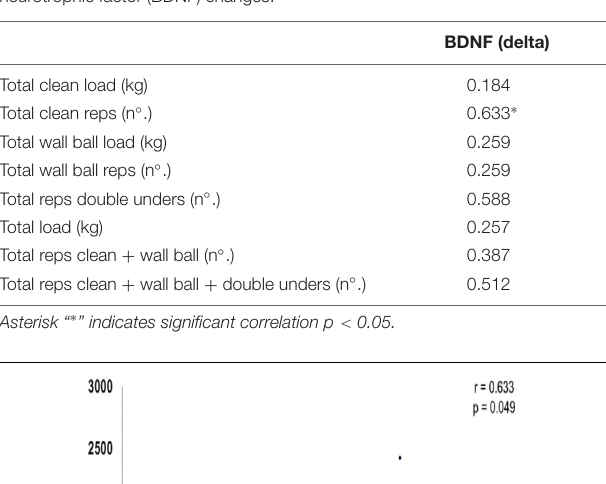
TABLE 2 | Correlation between total volume (series × replicates) and total load (total volume × weight) of training parameters with values of delta brain-derived neurotrophic factor (BDNF) changes.